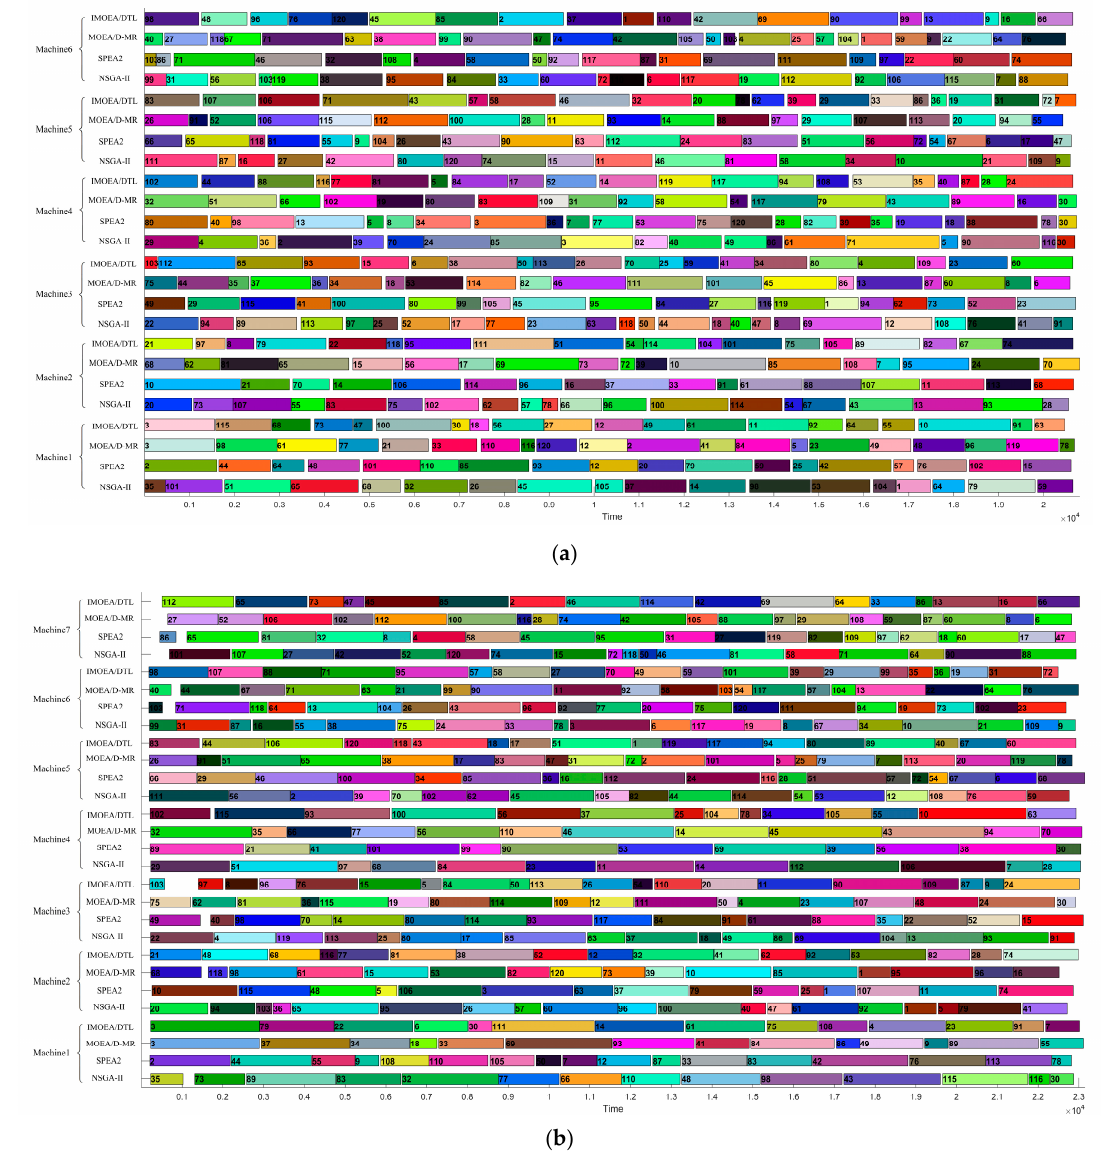
Figure 5. The Gantt charts of Job8, ( a , b ) are Gantt charts of the first and second operation of Job8 respectively; the makespan and energy cost of NSGA-II, SPEA2, MOEA/D-MR, and IMOEA/DTL are (2.3041 × 10 4 , 1.9083 × 10 6 ), (2.3147 × 10 4 , 1.9133 × 10 6 ), (2.3112 × 10 4 , 1.9117 × 10 6 ), and (2.3017 × 10 4 , 1.9041 × 10 6 ),